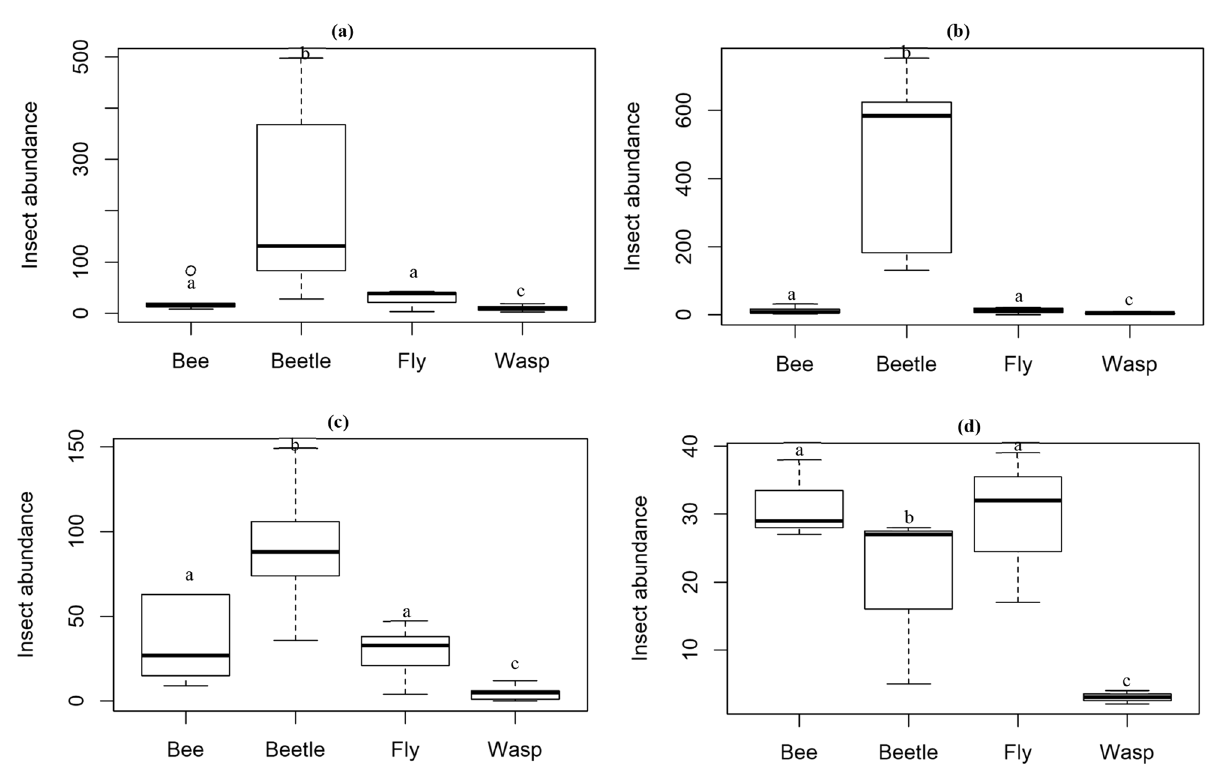
Figure 3. Abundance of flower-visiting insects at the ( a ) base zone, ( b ) middle zone, ( c ) high zone, and ( d ) summit zone among taxonomic groups. Taxa with common letters are not significantly different at p >